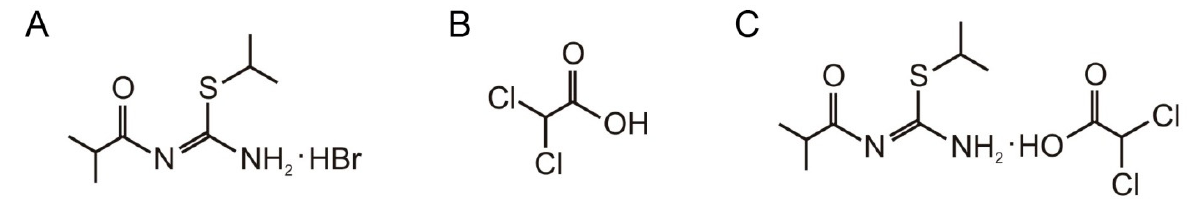
Figure 1. Structural formulas of the compounds studied. ( A ) 1-isobutanoyl-2-isopropylisothiourea hydrobromide (compound T1023); ( B ) dichloroacetate (DCA); ( C ) 1-isobutanoyl-2-isopropylisothiourea dichloroacetate (compound T1084).